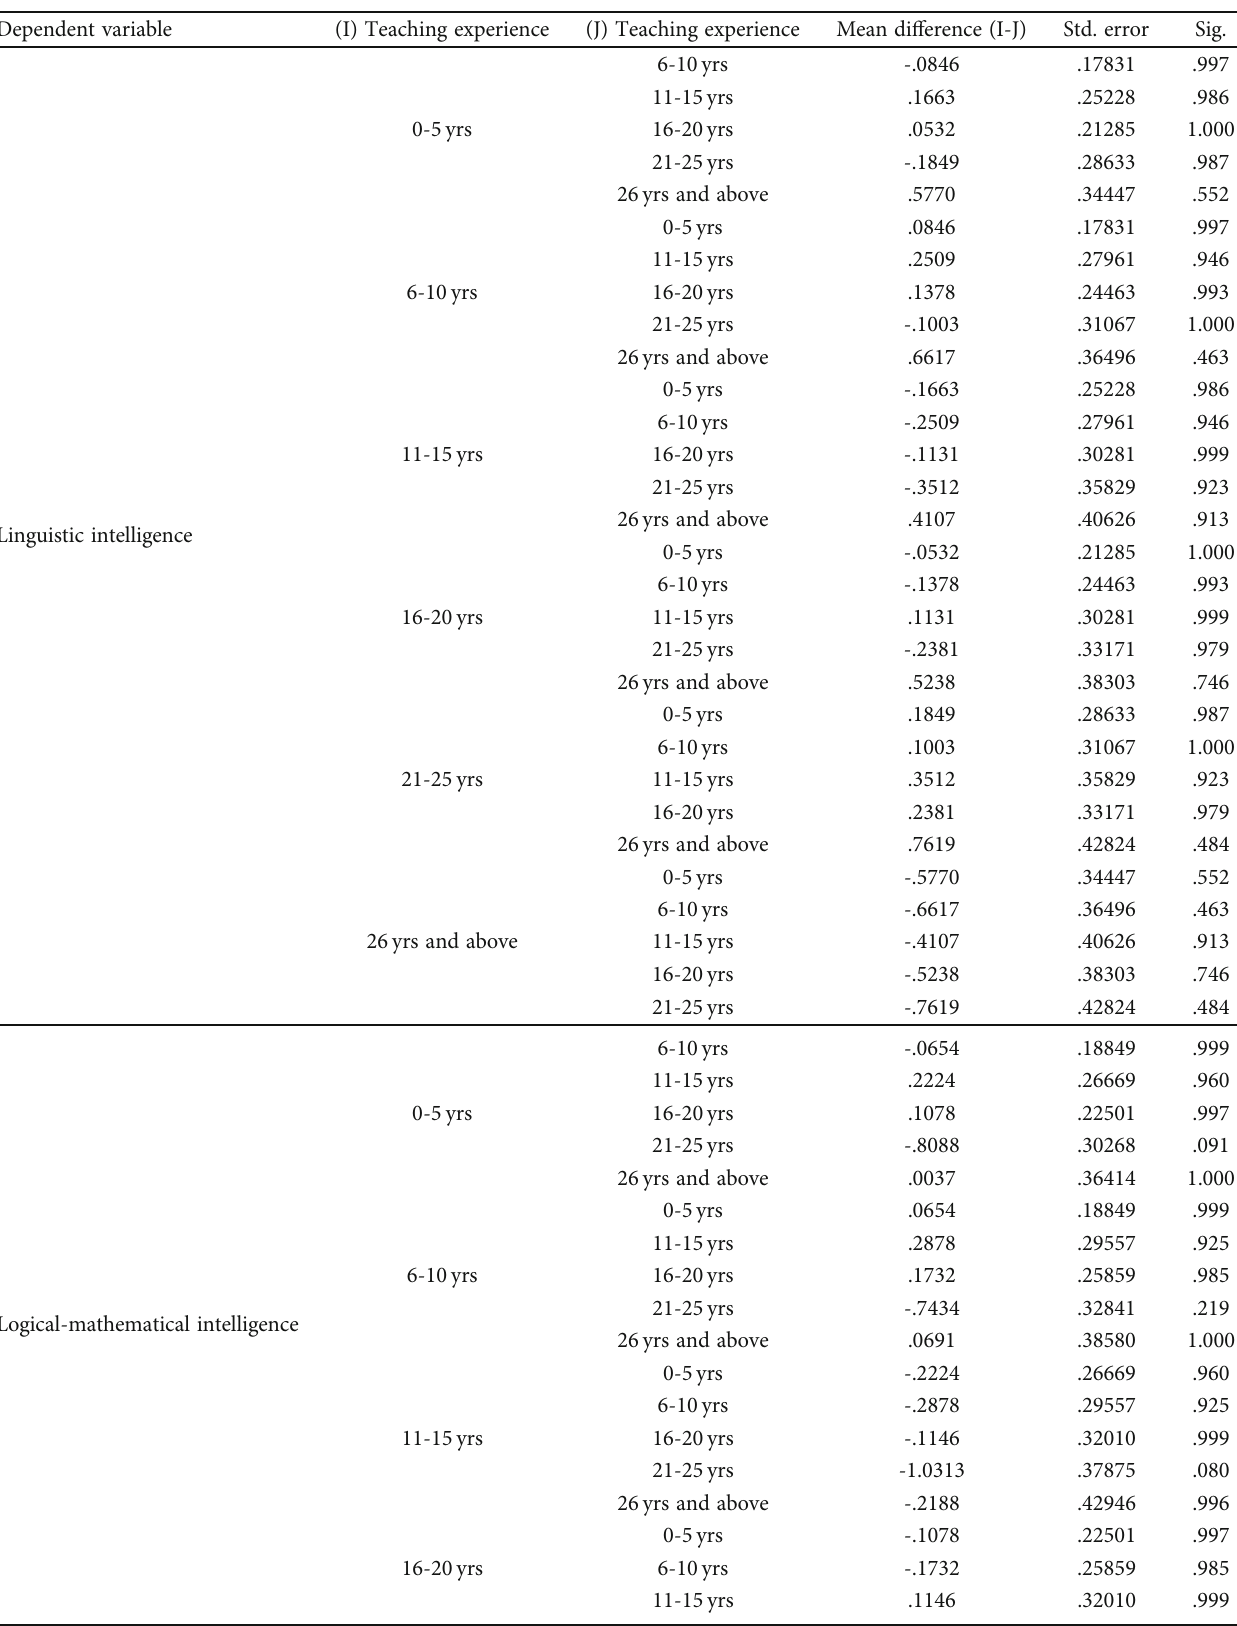
Table 5: Multiple